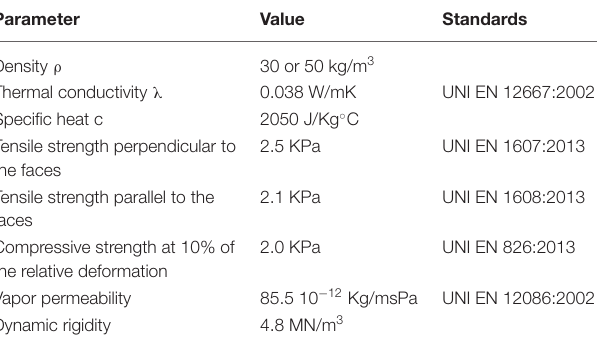
TABLE 4 | Kenaf characteristics.